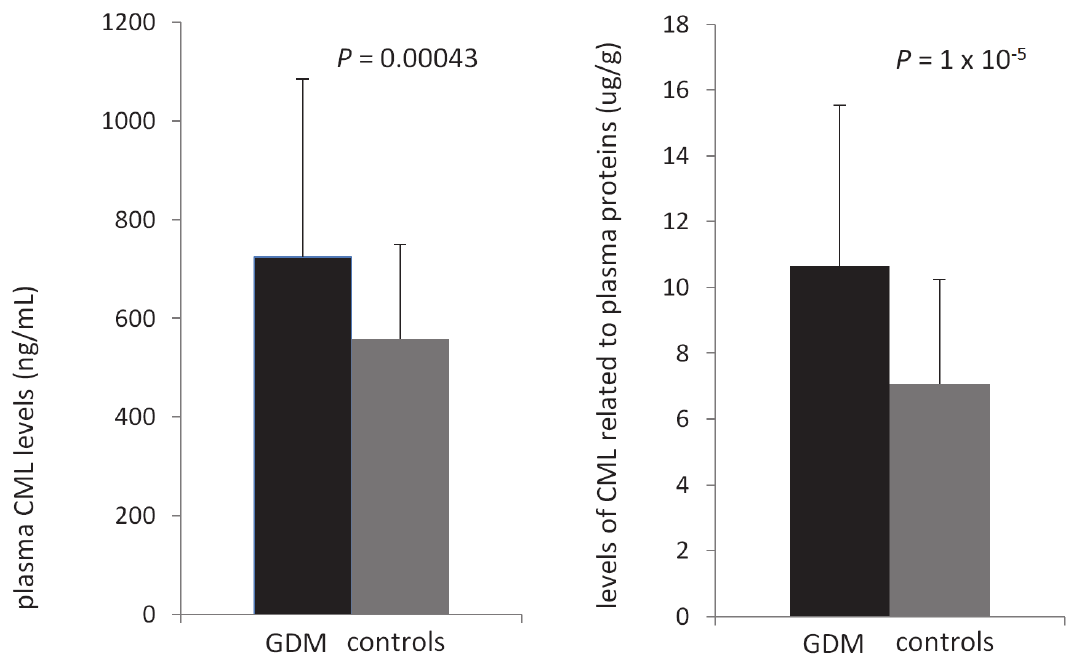
Fig. 1. Plasma unadjusted and total plasma protein adjusted CML in GDM women (n=182) and healthy pregnant women (n=36) in mid trimester of